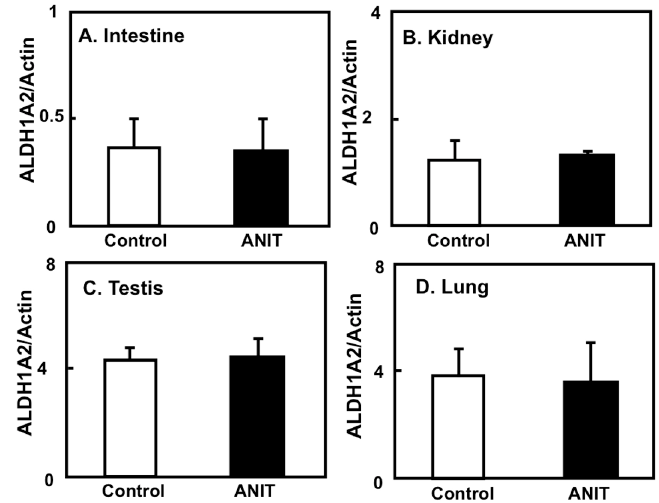
Figure 9. ALDH1A2 gene expression of several tissues in both control and ANIT rats. The ALDH1A2 mRNA levels of tissues including intestine ( A ), kidney ( B ), testis ( C ), and lung ( D ) were examined by quantitative real-time PCR in treated and control groups ( n = 5 for each group). Each bar represents the mean value ± SD and significant differences are indicated in the graph.